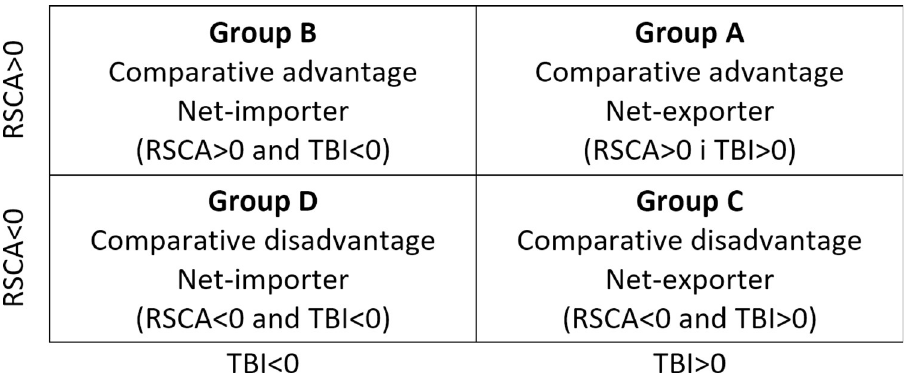
Fig 1. Products mapping by the RSCA and TBI values in line with the Widodo approach. Source: Widodo [37].